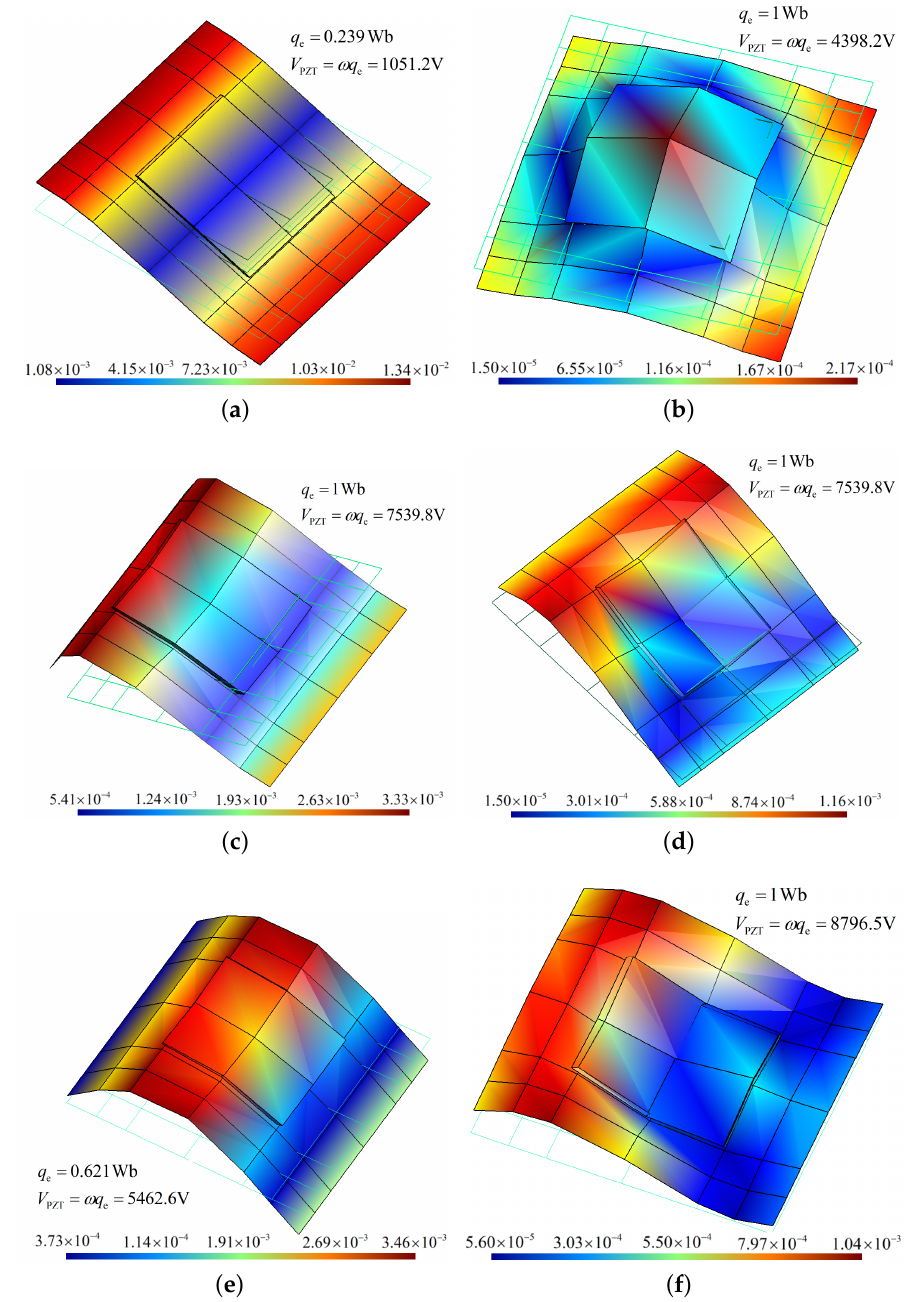
Figure 7. Waveshapes of: ( a ) wave 1 at 700 Hz; ( b ) wave 2 at 700 Hz; (B) wave 1 at 1200 Hz; ( d ) wave 2 at 1200 Hz; ( e ) wave 1 at 1400 Hz; ( f ) wave 2 at 1400 Hz. The MAC (modal assurance criterion) between ( a ) and ( b ) is 0.0097, MAC between ( c ) and ( d ) is 0.8420, MAC between ( e ) and ( f ) is 0.2048. The waveshapes are normalized such that the amplitude of the largest DOFs is